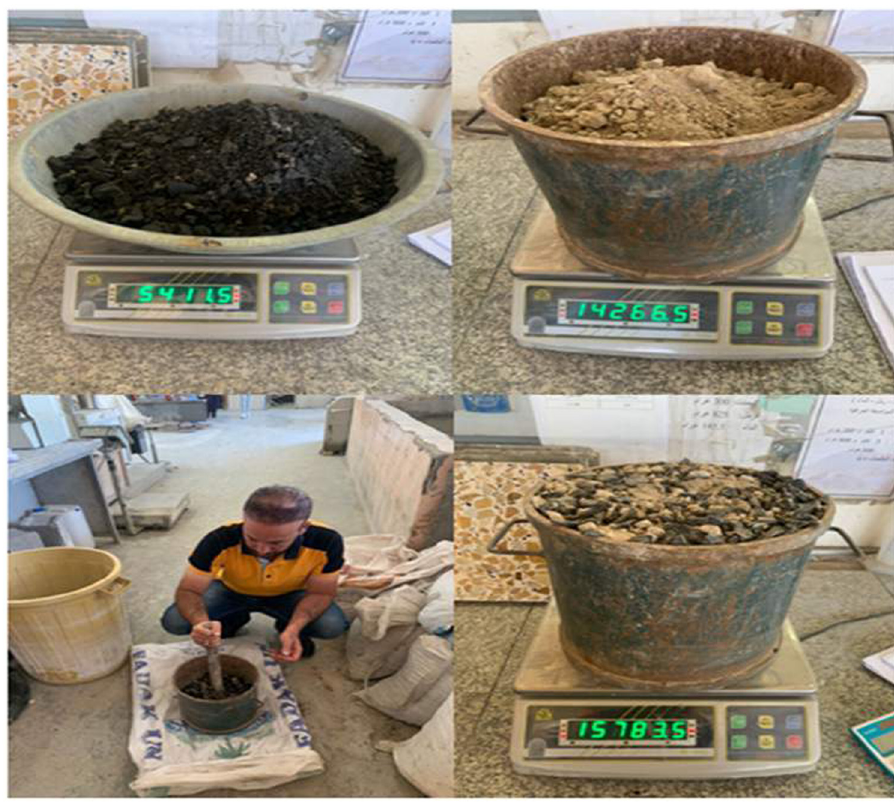
Figure 12: Determination of the mixture densities.